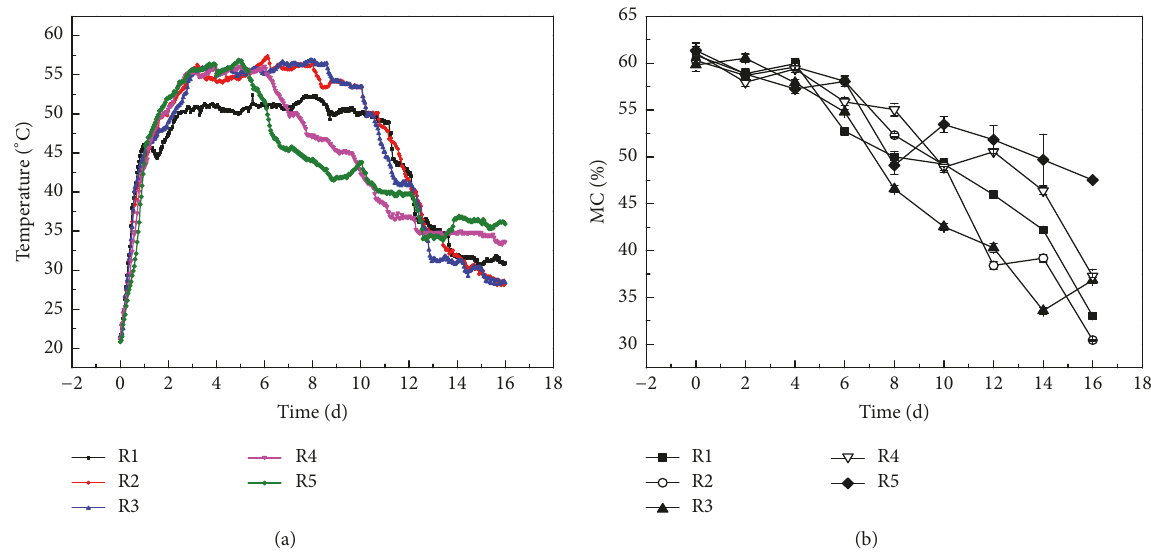
Figure 5: (a) Temperature for the composting of KW and (b) MC for the composting of KW.